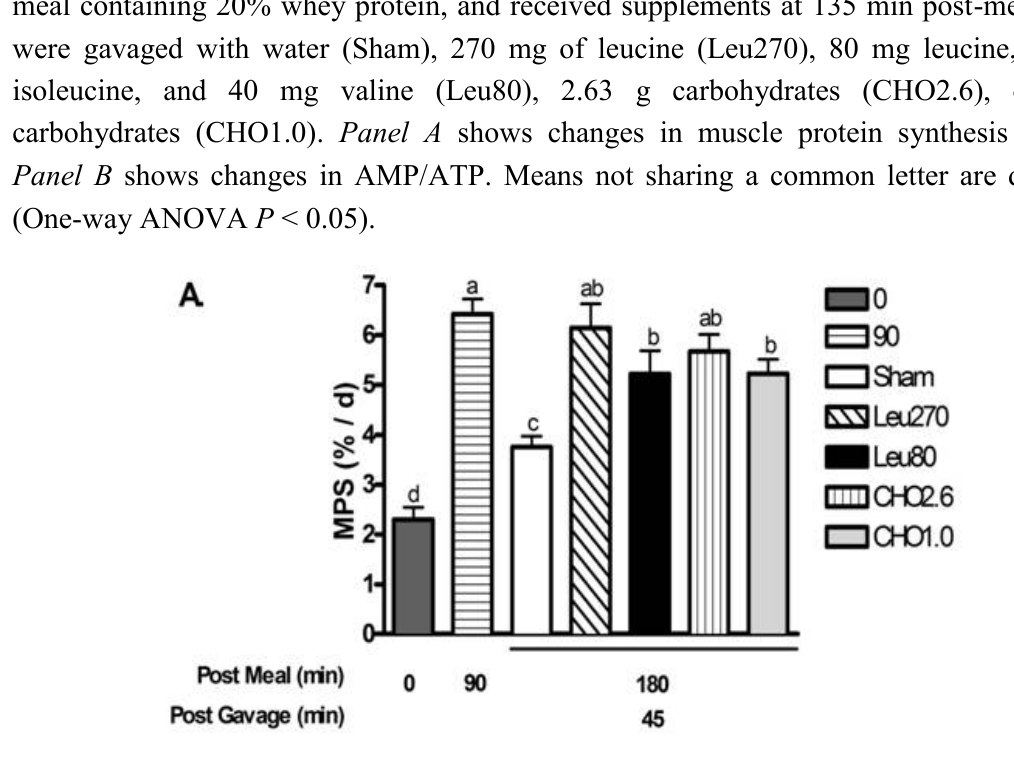
Figure 3. Postprandial changes for muscle protein synthesis (MPS) and AMP/ATP